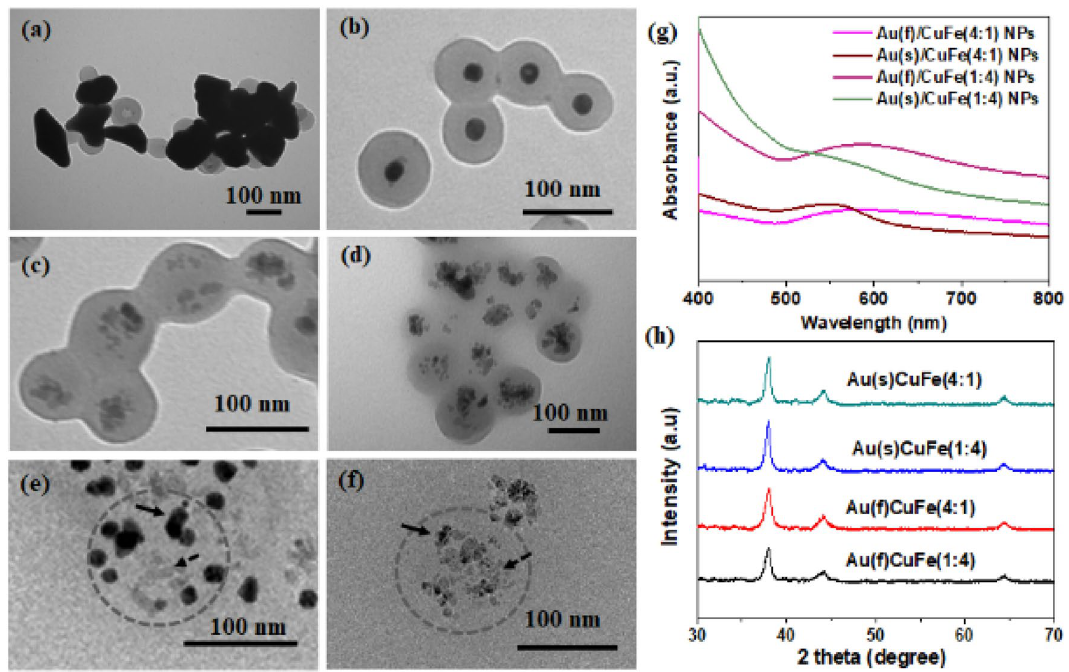
Figure 2. TEM images of the Au-doped Cu/Fe oxide-polymer nanoreactor synthesized with the different reaction parameters ( a ) Au(f)/CuFe(4:1), ( b ) Au(s)/CuFe(4:1), ( c ) Au(f)/CuFe(1:4), ( d ) Au(s)/CuFe(1:4), ), (e) HRTEM images of Au(f)/CuFe(1:4), ( f ) HRTEM images of Au(s)/CuFe(1:4) ( g ) UV–vis spectra, (h) XRD